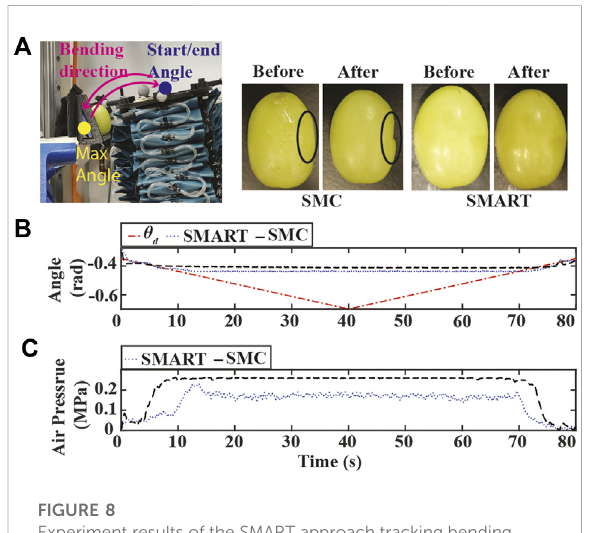
FIGURE 8 Experiment results of the SMART approach tracking bending anglewithcompliantobstacle. (A) Experimentsetupandimagesof green grapes. (B) Bending angle tracking results where θ d is the original desired bending angles (dash-dotted red) (C) Air pressure measurements of chamber 1.